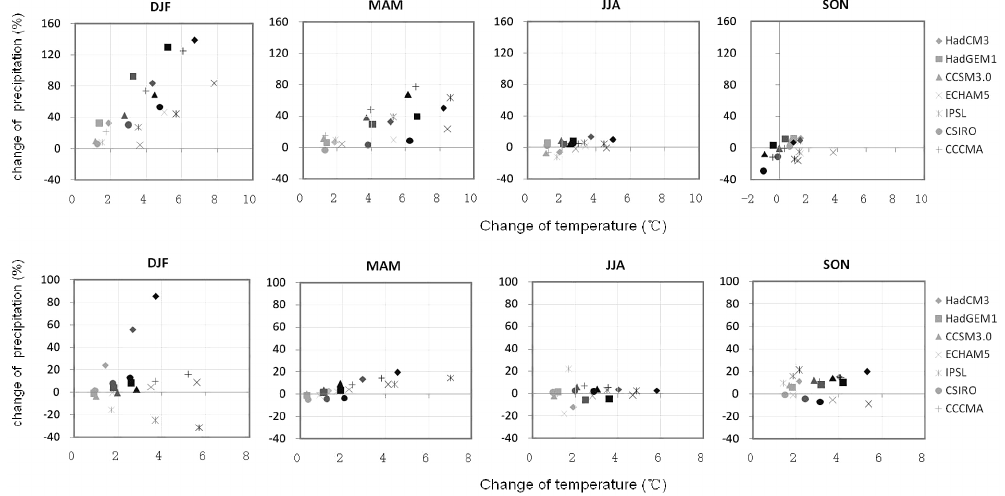
Figure 3. Scatter plots of seasonal temperature and precipitation changes for seven GCM projections for the 2020s, 2050s and 2080s time horizons for the rivers Huangfuchuan (top) and Xiangxi (bottom) (compared to the 1961–1990 baseline; 2020s: light grey; 2050s: dark grey; 2080s: black).